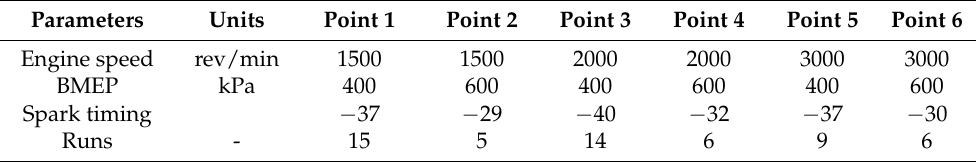
Table 3. Target engine speed and brake mean effective pressure of the 1st experiment.